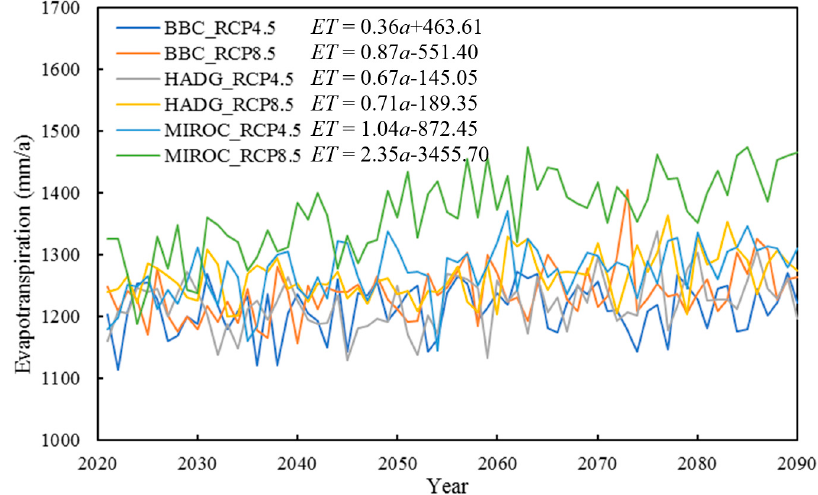
Figure 5. The trend of the evapotranspiration of Hotan Station under the six scenarios.